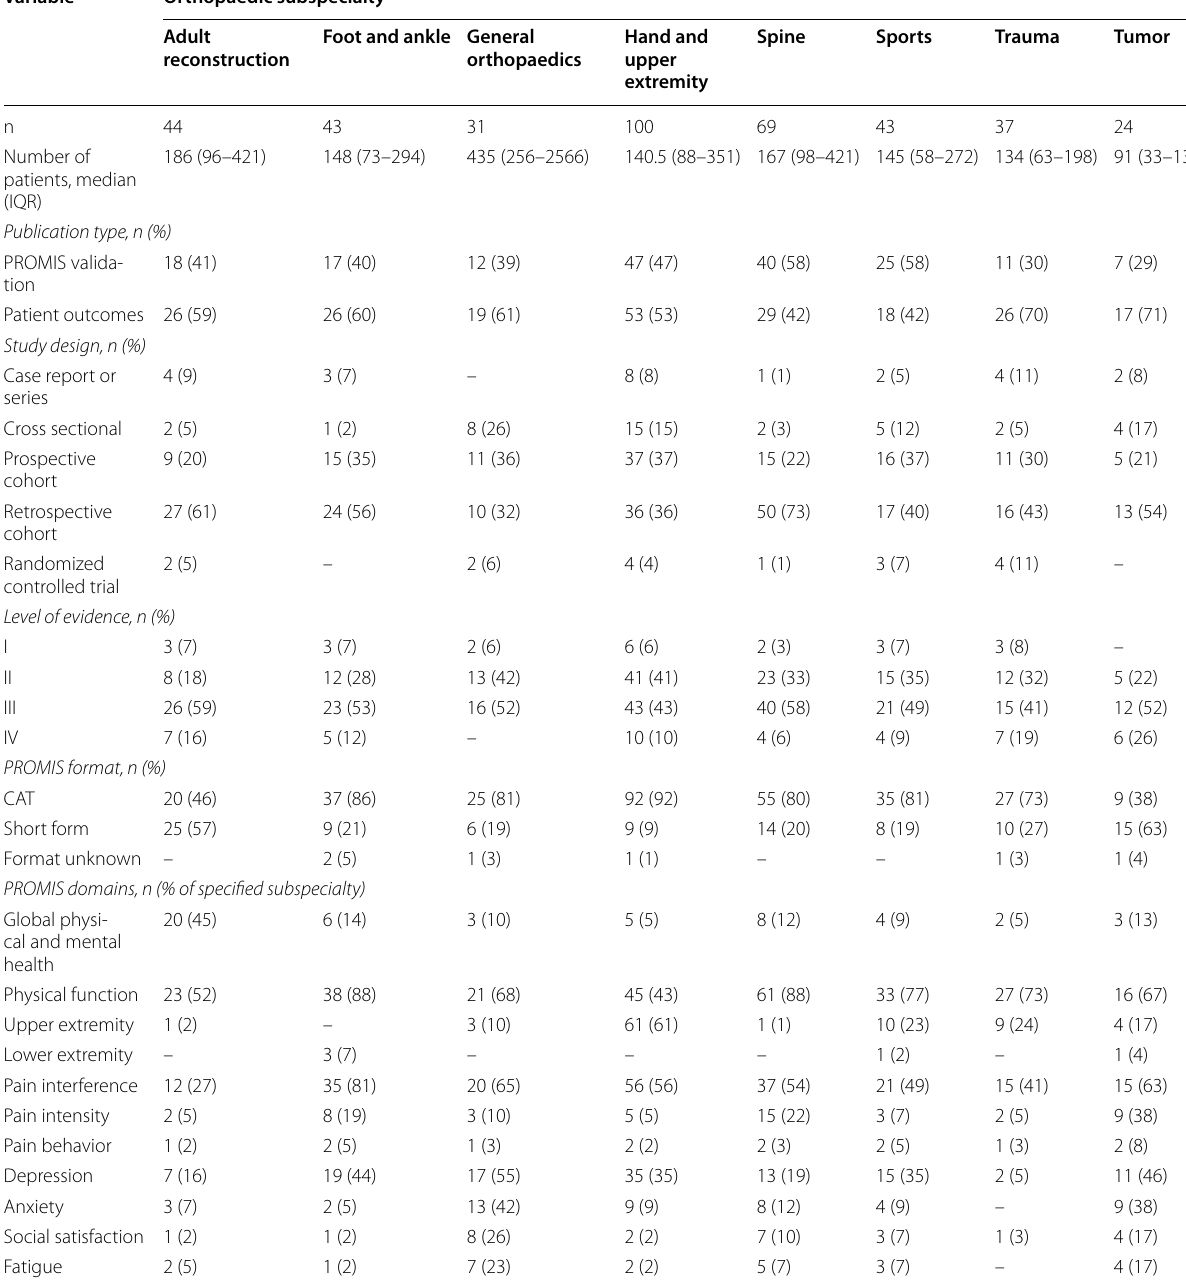
IQR interquartile range, CAT computerized adaptive